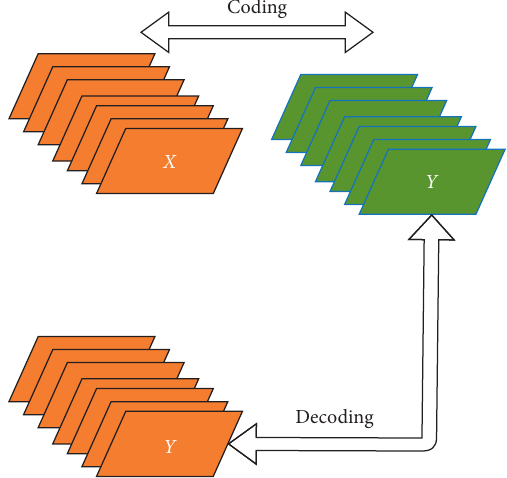
Figure 8: Convolutional autoencoder.